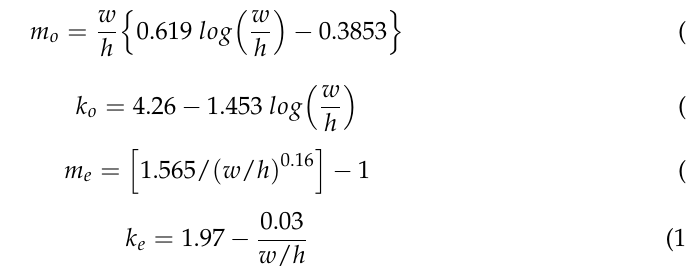
Figure 3. Circuit model representation of the microstrip line with gap including film.